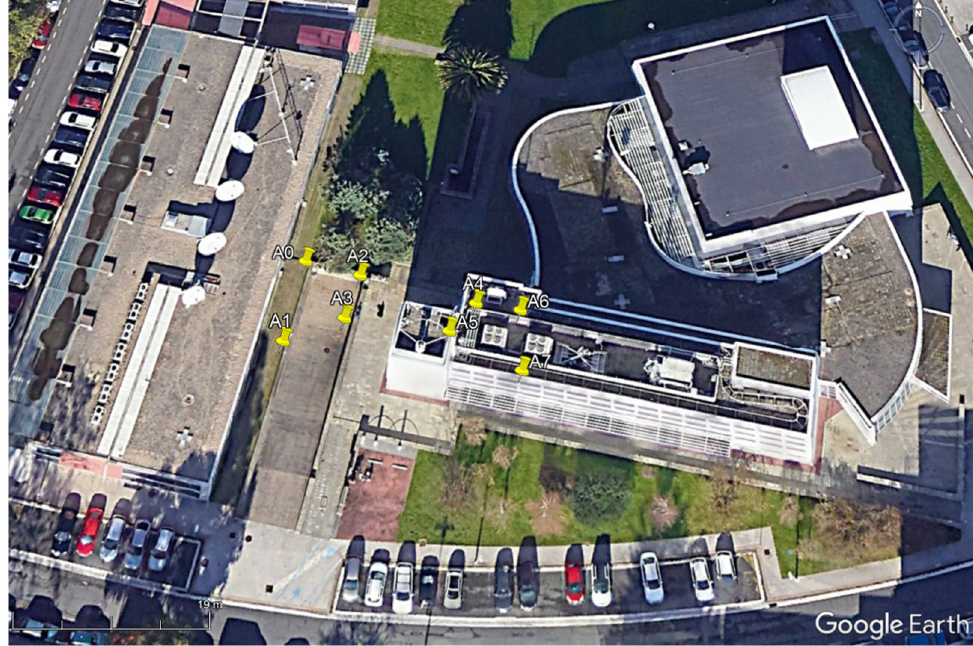
Figure 8. Distribution of the UWB anchors within the garage